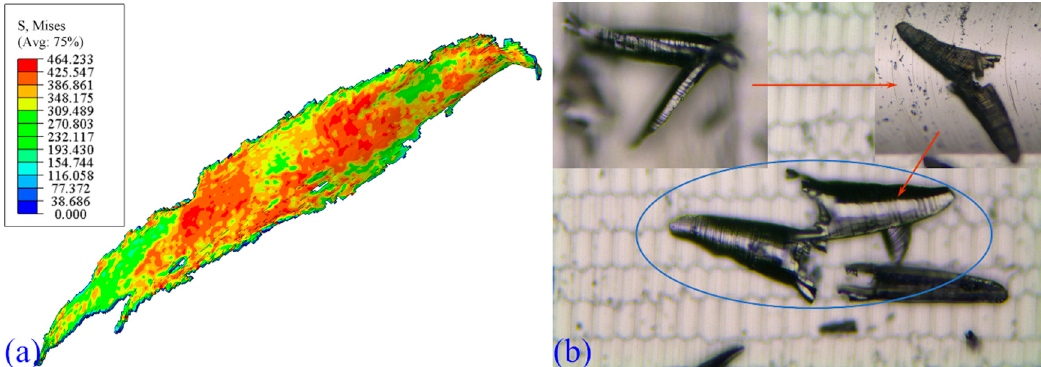
Figure 6. Chip profile obtained in the diamond micro milling process of the Cu workpiece by the ( a ) FE simulation and ( b ) experiment.